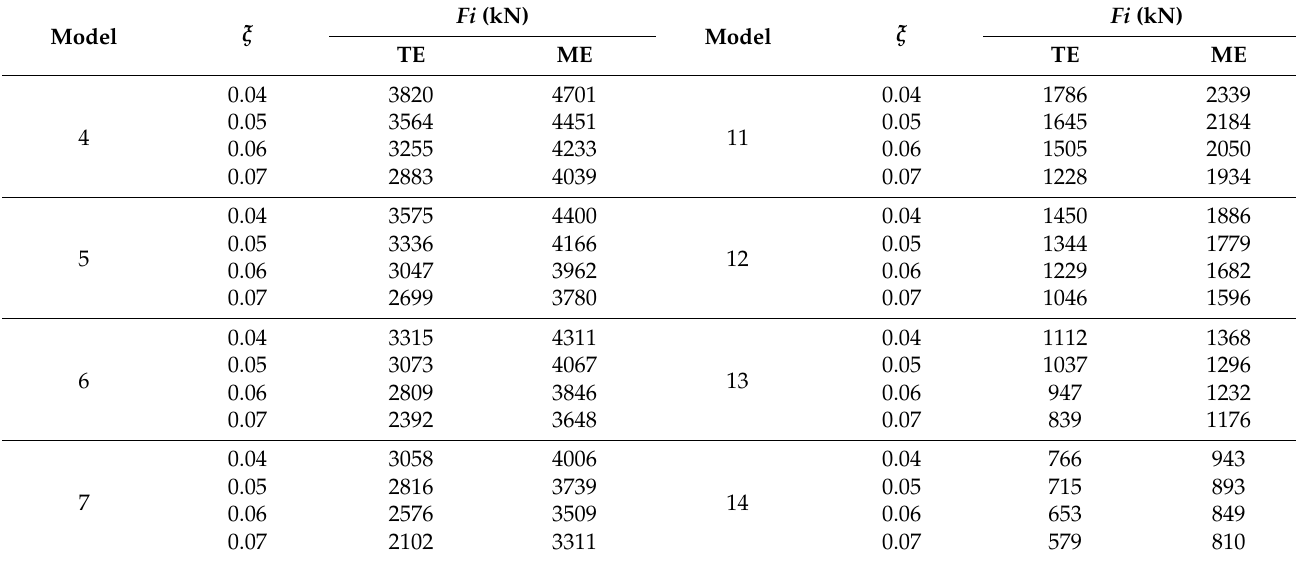
Figure 12. FEA of the ME waveform: Residual displacement.